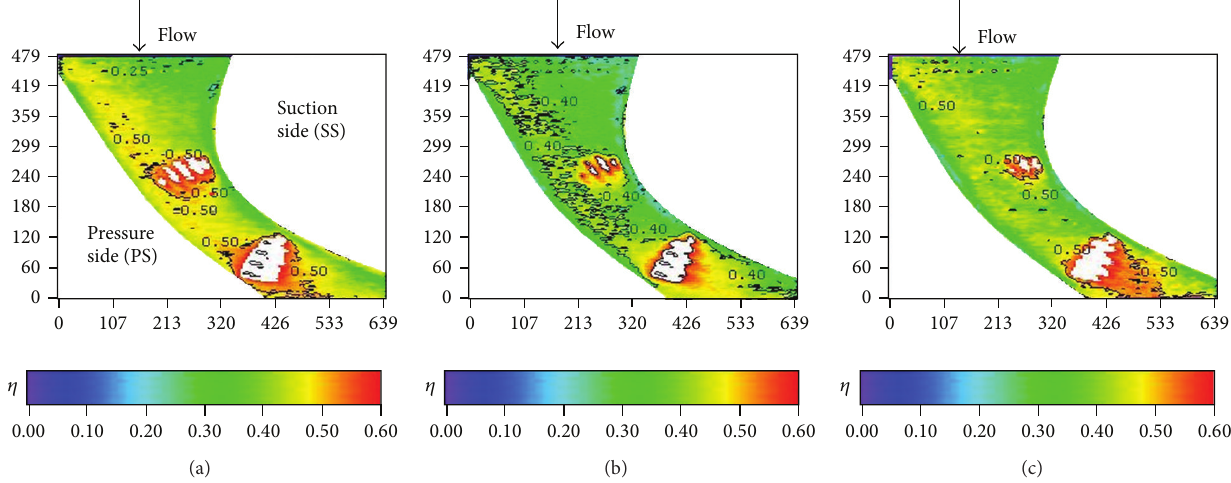
Figure 6: Distributions of local effectiveness at high turbulence intensity ( 𝑆/𝐶 = 0 %, 𝑀 = 1 , and T . I . = 12 %). (a) Re = 92000 . (b) Re = 124000 . (c) Re = 150000 .